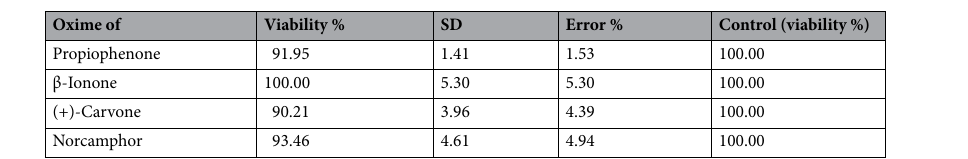
Figure 1. Images of HEK293T cell lines from a Nikon Eclipse TS2R microscope. ( A ) Control well. With added tested agents: ( B ) Propiophenone oxime, ( C ) β-ionone oxime, ( D ) (+)-carvone oxime, and E. norcamphor oxime. On comparison of the images, it can be stated that the tested compounds do not affect the morphology or viability of the cell line.